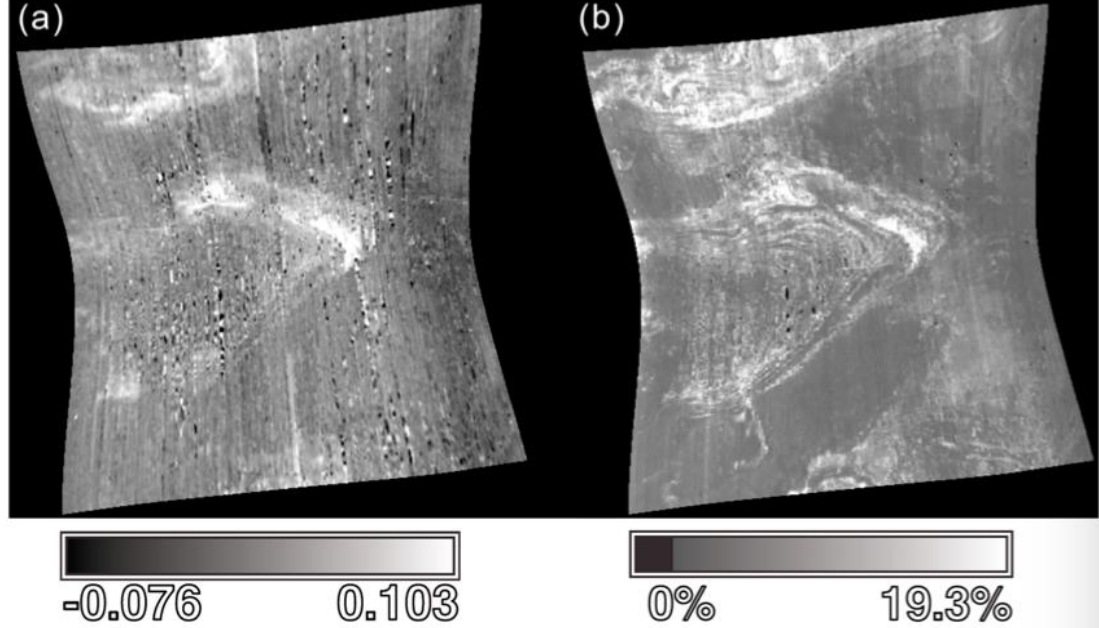
Figure. 6. The jarosite distribution in FRT00013F5B (Liu et al. 2016). a) CRISM parameter index map for Jarosite b) Modeled jarosite